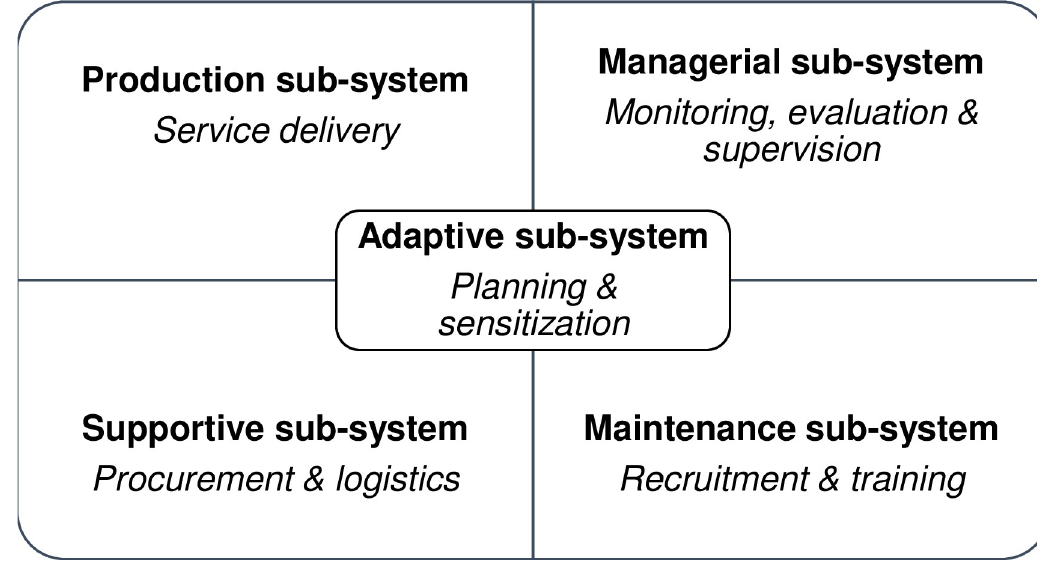
Fig 2. Organizational subsystems in Kenya’s HTS program based on conceptual